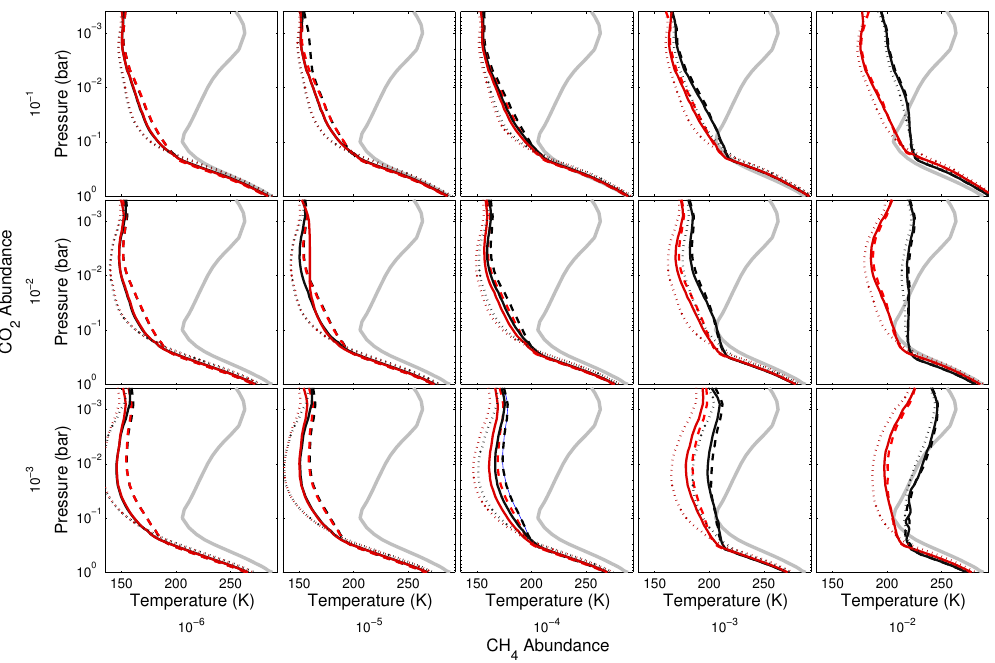
Figure 6. Atmospheric temperature profiles. Equilibrium temperature profiles (K) as functions of CO 2 and CH 4 abundances. Line types and colours are as in Fig. 4. Grey line shows the global and annual mean temperature profile for the modern atmosphere.